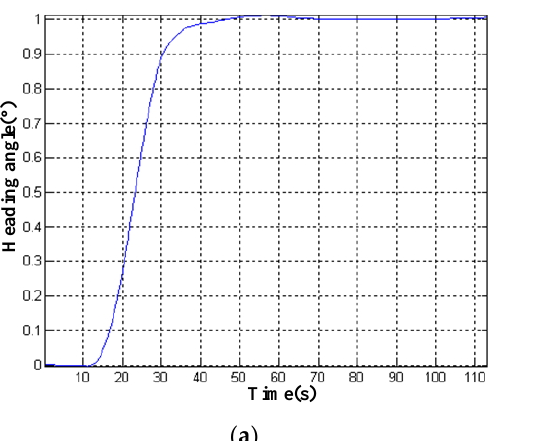
Figure 19. Step Response of traditional PID Controller . ( a ) heading; ( b ) controlled quantity.